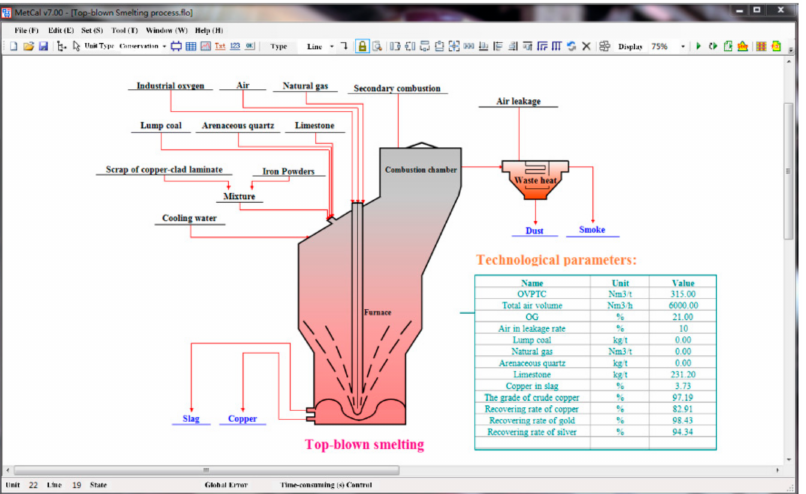
Figure 3. The interface of the thermodynamic simulation system for the top-blowing smelting process of electronic